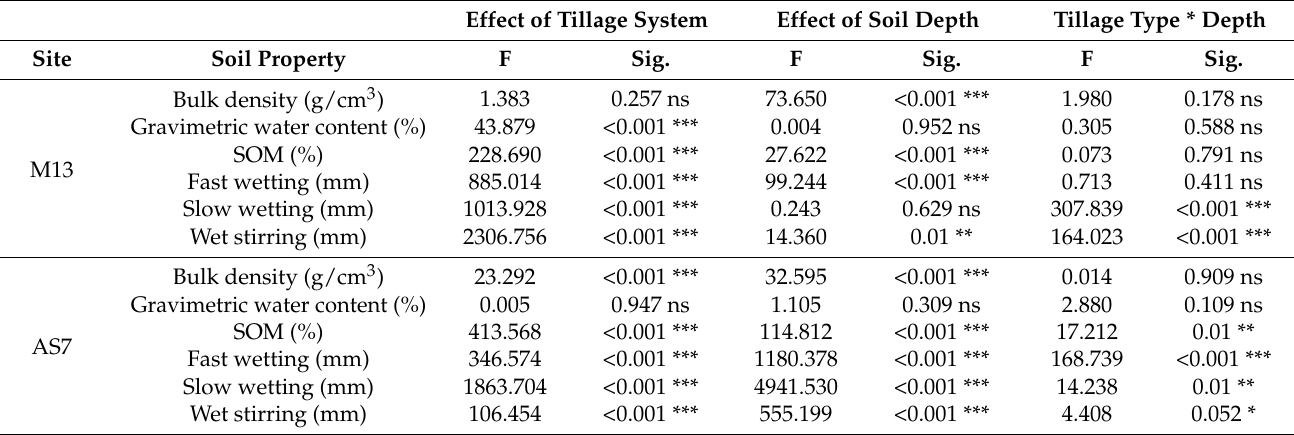
Table 4. ANOVA for the effect of tillage type (NT and CT) and depth on the physical properties of the soil at site